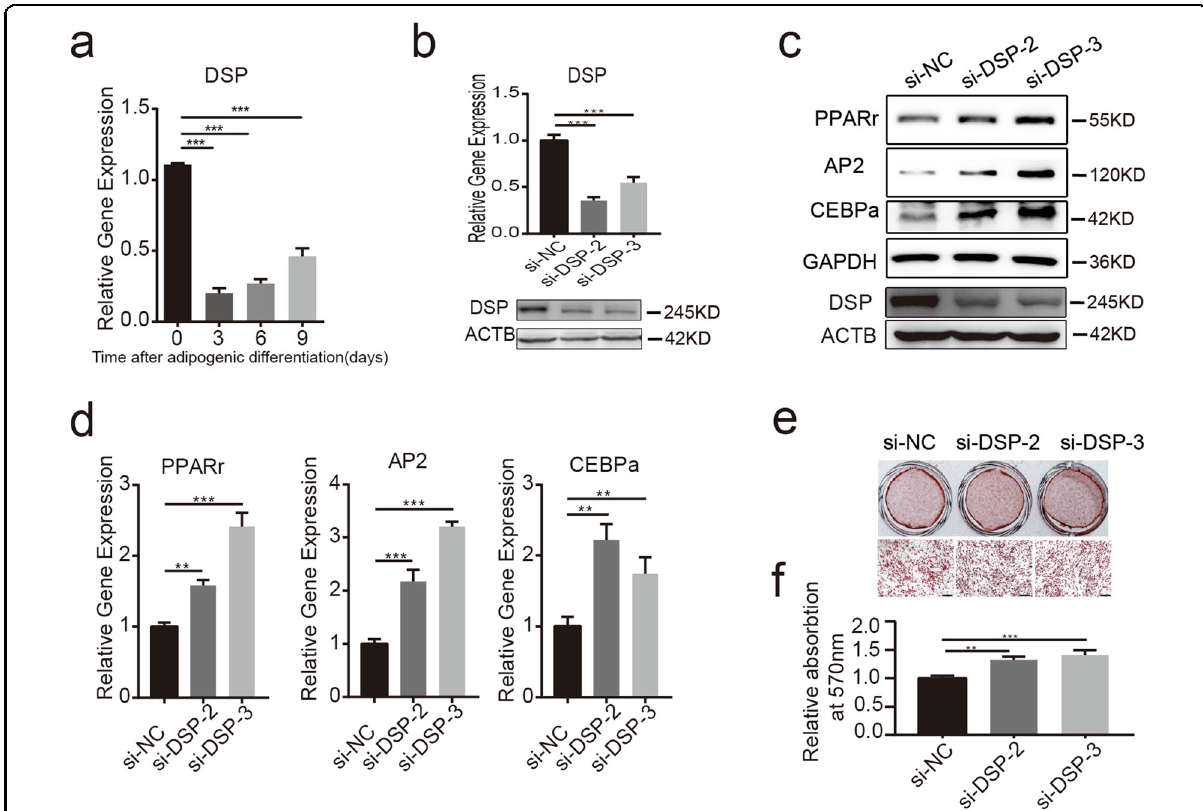
Fig. 5 Desmoplakin negatively regulates the adipogenic differentiation of hAMSCs. a qRT-PCR analysis veri fi ed the DSP expression pro fi le at the indicated time points after adipogenic differentiation of hAMSCs. b DSP was silenced in hAMSCs using two independent siRNAs (si-DSP-2 and si- DSP-3). The knockdown ef fi ciency was veri fi ed by qRT-PCR (upper) and western blotting (lower) as compared with the negative control (si-NC). c , d Western blot analysis ( c ) and qRT-PCR analysis ( d ) of adipogenic markers (PPAR γ , AP2, and CEBP α ) in DSP knockdown hAMSCs and control hAMSCs on day 3 after adipogenic induction. e , f Oil red O staining of adipose lipids in DSP knockdown hAMSCs and control hAMSCs on day 10 after adipogenic induction ( e ) and quanti fi cation of the oil red O staining ( f ). GAPDH and ACTB were used as internal controls for western blotting. The quantitative data were normalized to GAPDH, n = 3; data are shown as the mean ± SD; ** P < 0.01, *** P < 0.001; scale bars: 200